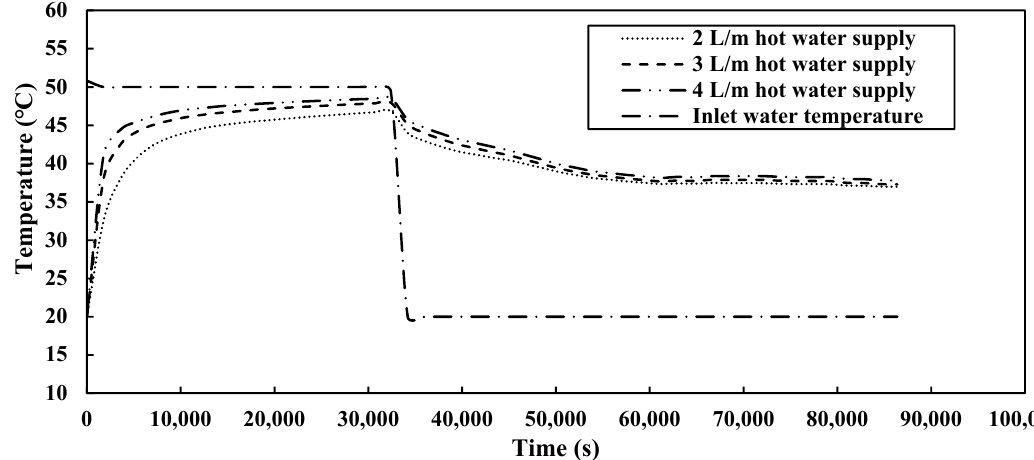
Figure 4. Storage tank inlet and outlet water temperatures.